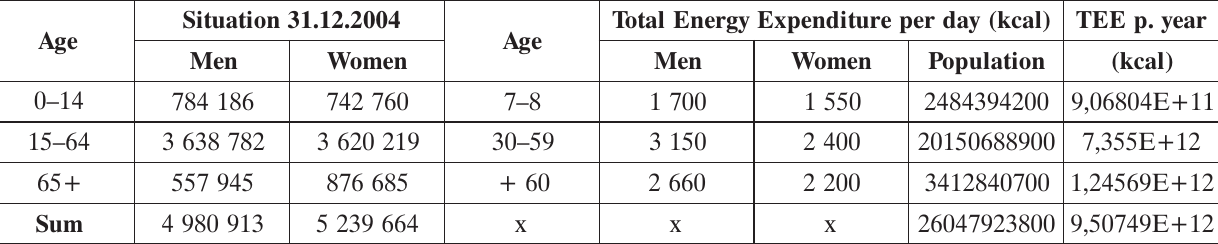
Table 6. Total Energy Expenditure of the Czech population per